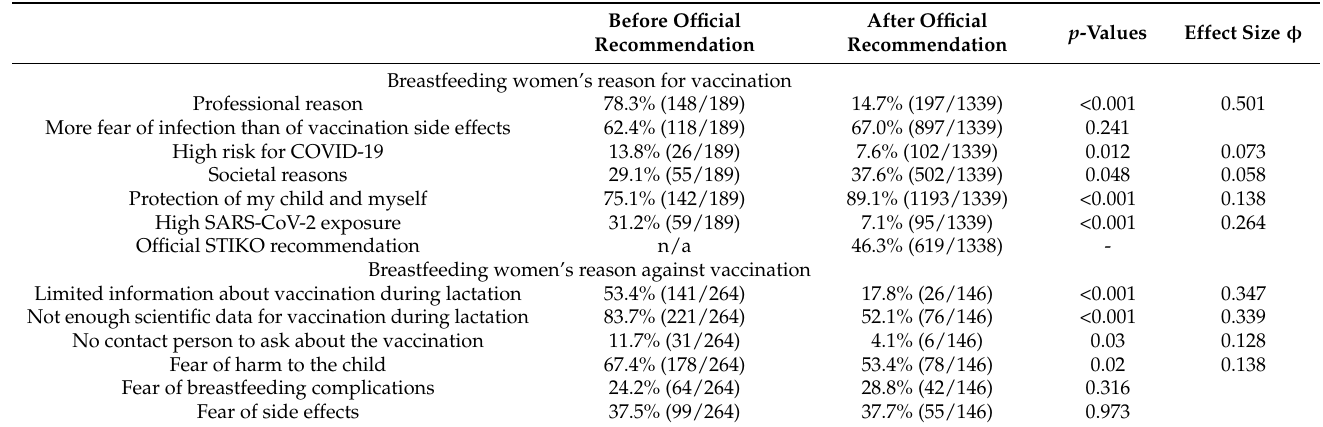
Table 3. Comparison of reasons for and against COVID-19 vaccination in breastfeeding women in relation to the publication of the STIKO